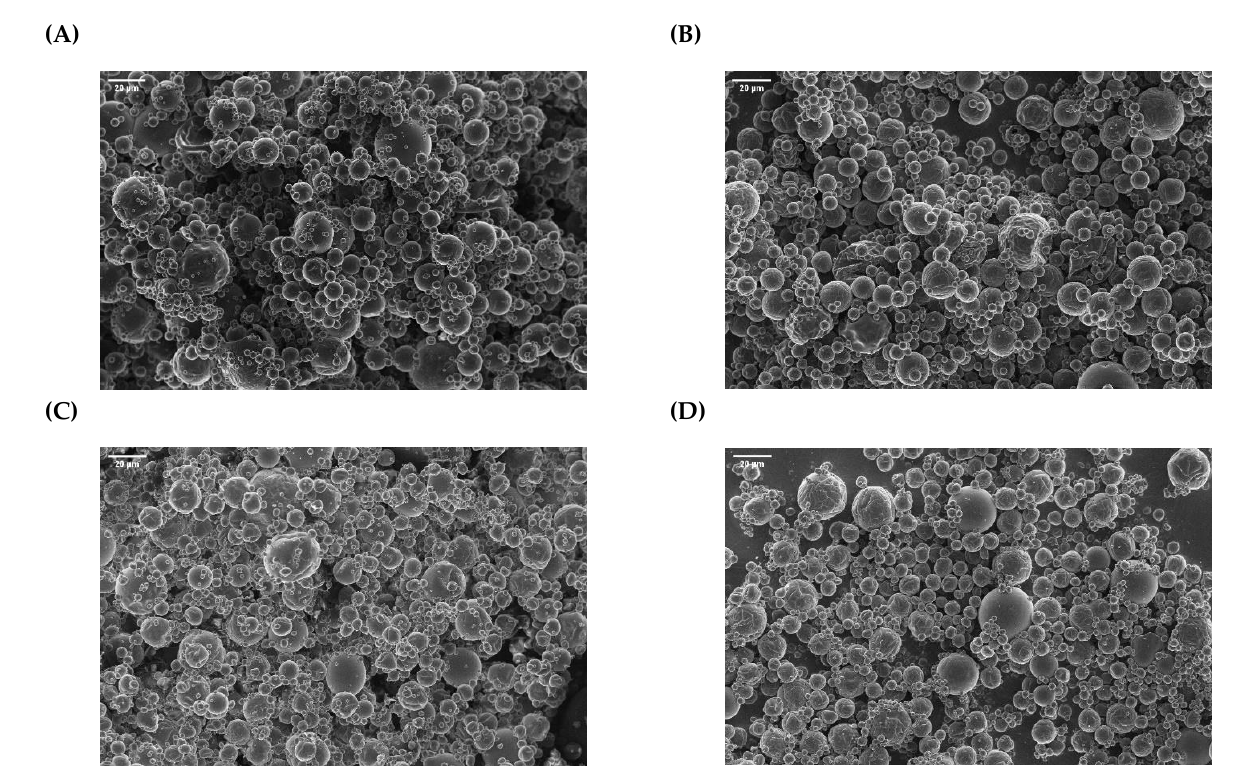
Figure 1. SEM images (A – D) of the spray-dried capsules loaded with fish oil: W-GS (A) ; T-GS (B) ; W-MD (C) ; T-MD (D) . Scale bar: 20 µm.